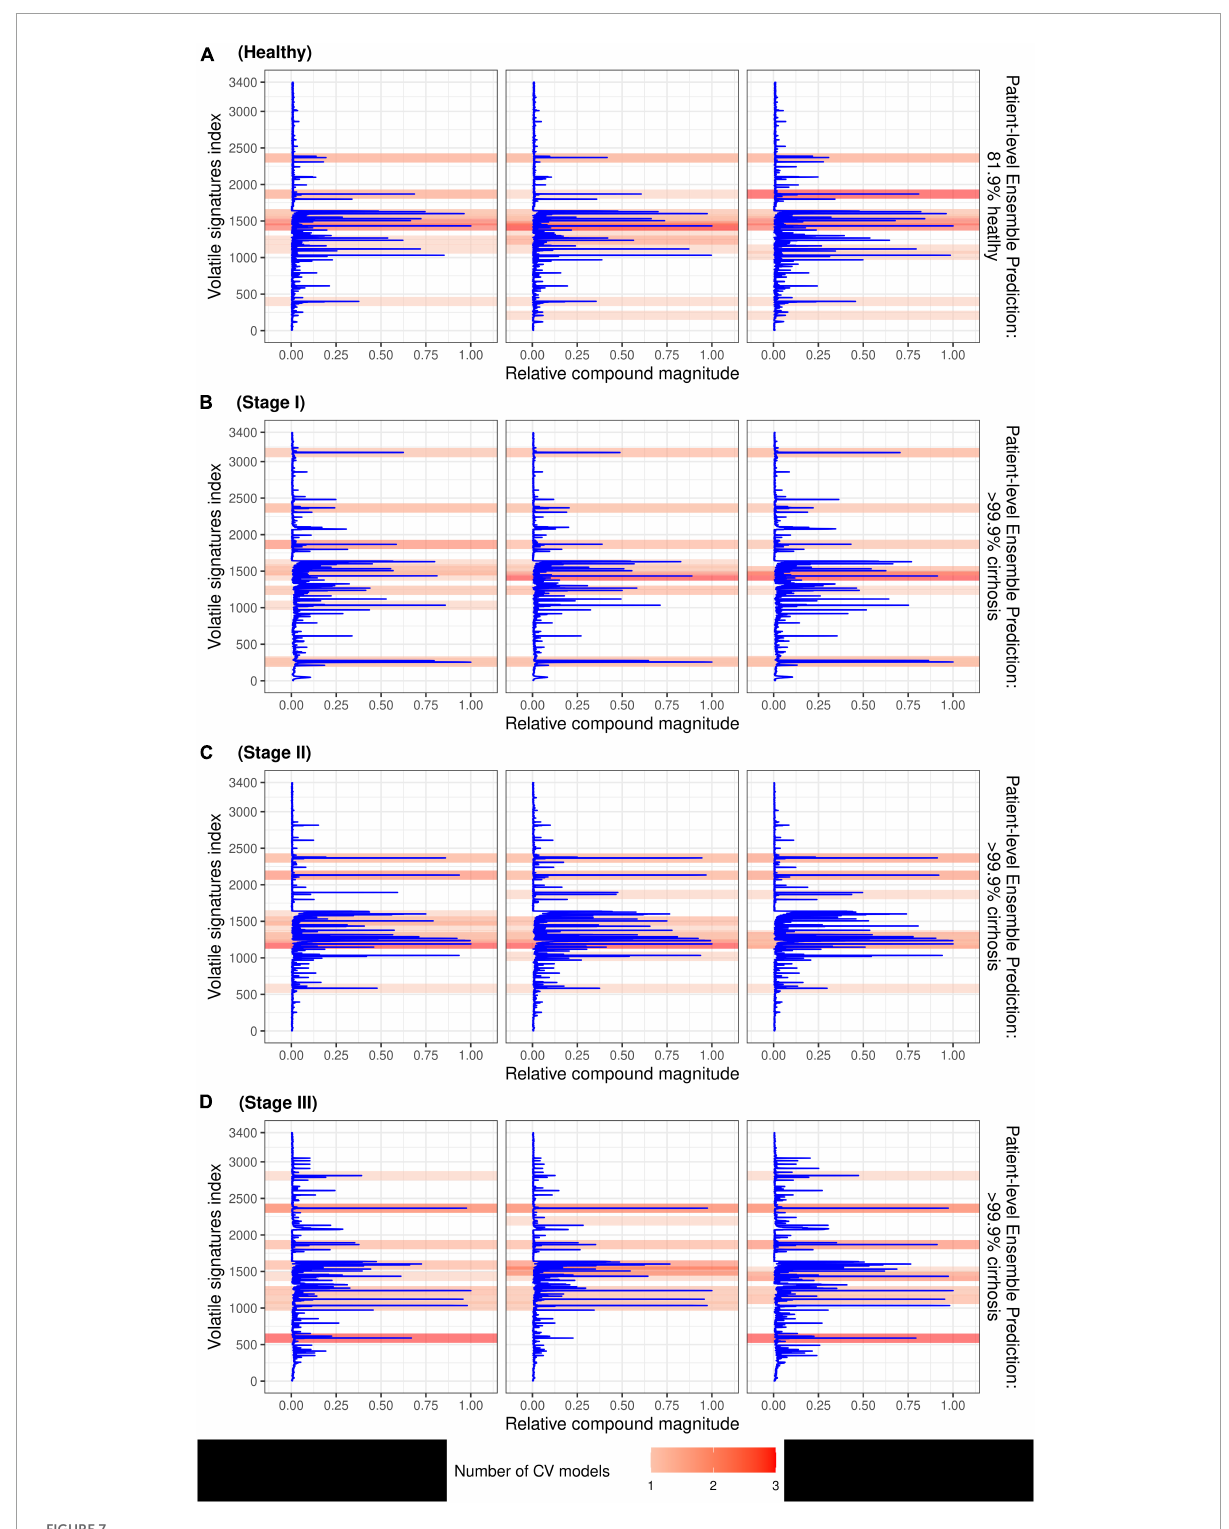
FIGURE7 Patient breath samples with overlayed heatmaps which identify the 5 most important peaks from each CV model (up to 20 peaks total) in the classification of liver cirrhosis for a healthy control (A) , and 3 individuals with stage I (B) , stage II (C) , and stage III (D) cirrhosis, respectively. Compounds are represented by indices on the y -axis and VOC signal value is on the x -axis; darker shading indicates the feature was selected by multiple CV